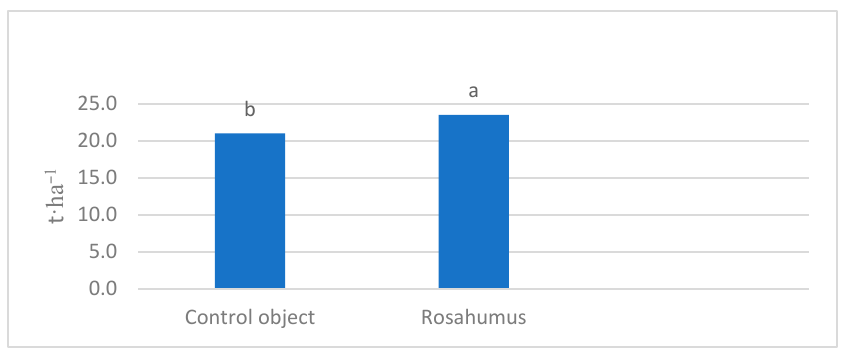
Figure 5. Effect of organic preparation Rosahumus on potato tuber yield. a,b-mean values indicated by the same letters are not statistically significant at the 0.05 level by Tukey’s test.